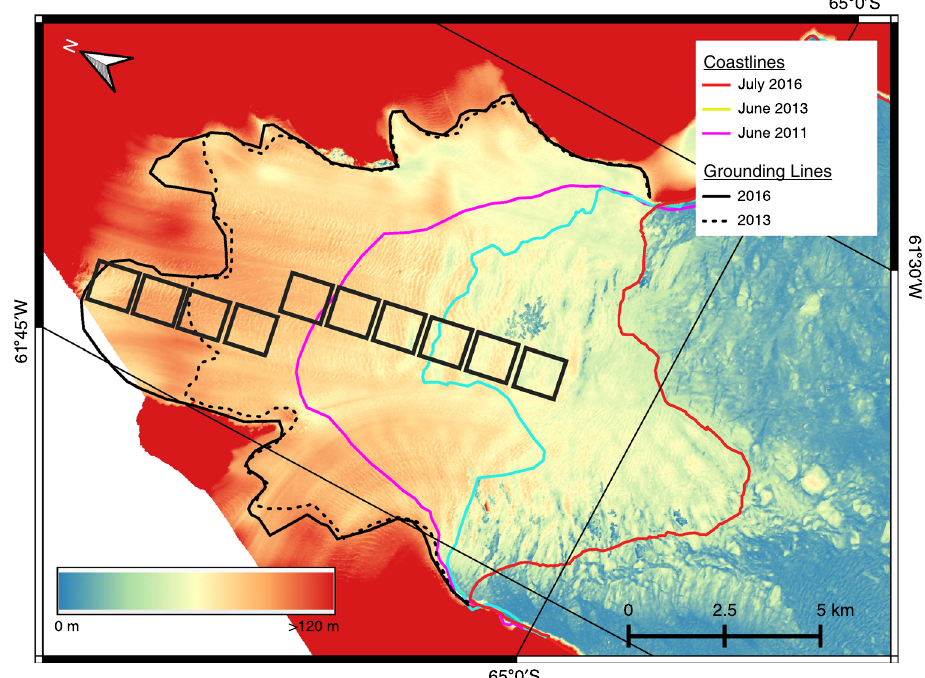
Fig. 1 Extent of fl oating ice on Hektoria Glacier terminus. TanDEM-X DEM of Hektoria and Green glacier terminus, 2016-07-27, with coastlines in June 2011, June 2013 and July 2016, grounding lines (GL) in June 2013 and July 2016. Colour code for altitude from 0 to ≥ 120 m a.s.l. The GL location is based on break in slope in the DEM and maps of surface elevation change 2013 – 2016 4 . The black boxes show the sites of the velocity data of ref. 1 .